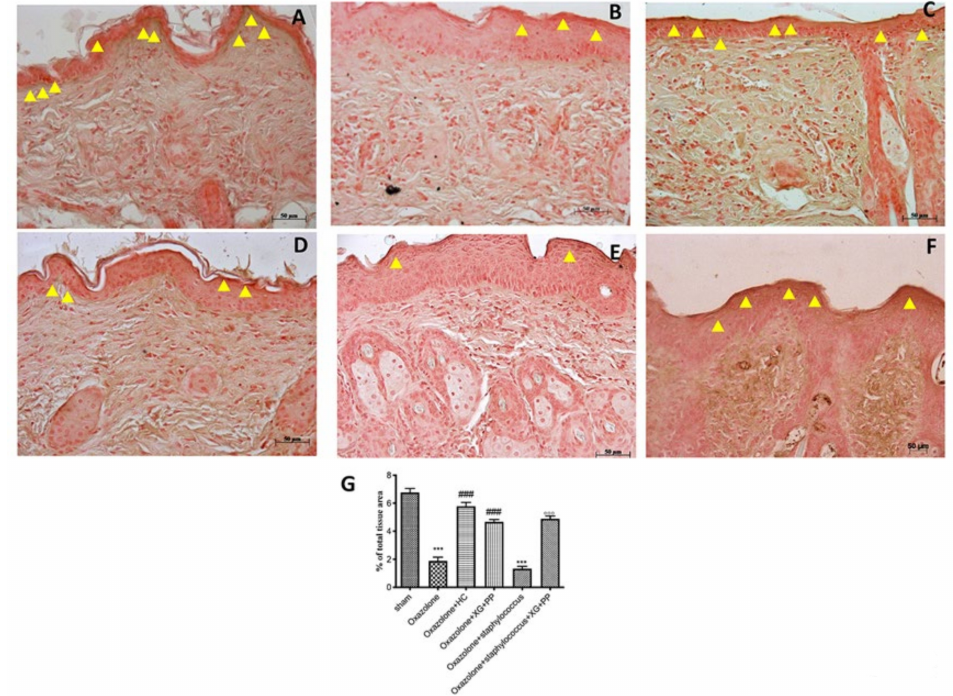
Figure 4. E ff ects of xyloglucan and pea protein on filaggrin expression: Immunohistochemical analysis of filaggrin was performed. A marked reduction of filaggrin was detected in the epidermal tissue of mice that received oxazolone ( B , G ) and oxazolone + S. aureus treatments ( E , G ) compared to sham-operated mice ( A , G ). Filaggrin expression was restored to near-endogenous levels by administration of hydrocortisone ( C , G ) and with XG + PP treatment in both in vivo models ( D , G and F , G respectively). *** p < 0.001 vs. sham; ### p < 0.001 vs. oxazolone; ◦◦◦ p < 0.001 vs. oxazolone + Staphylococcus.